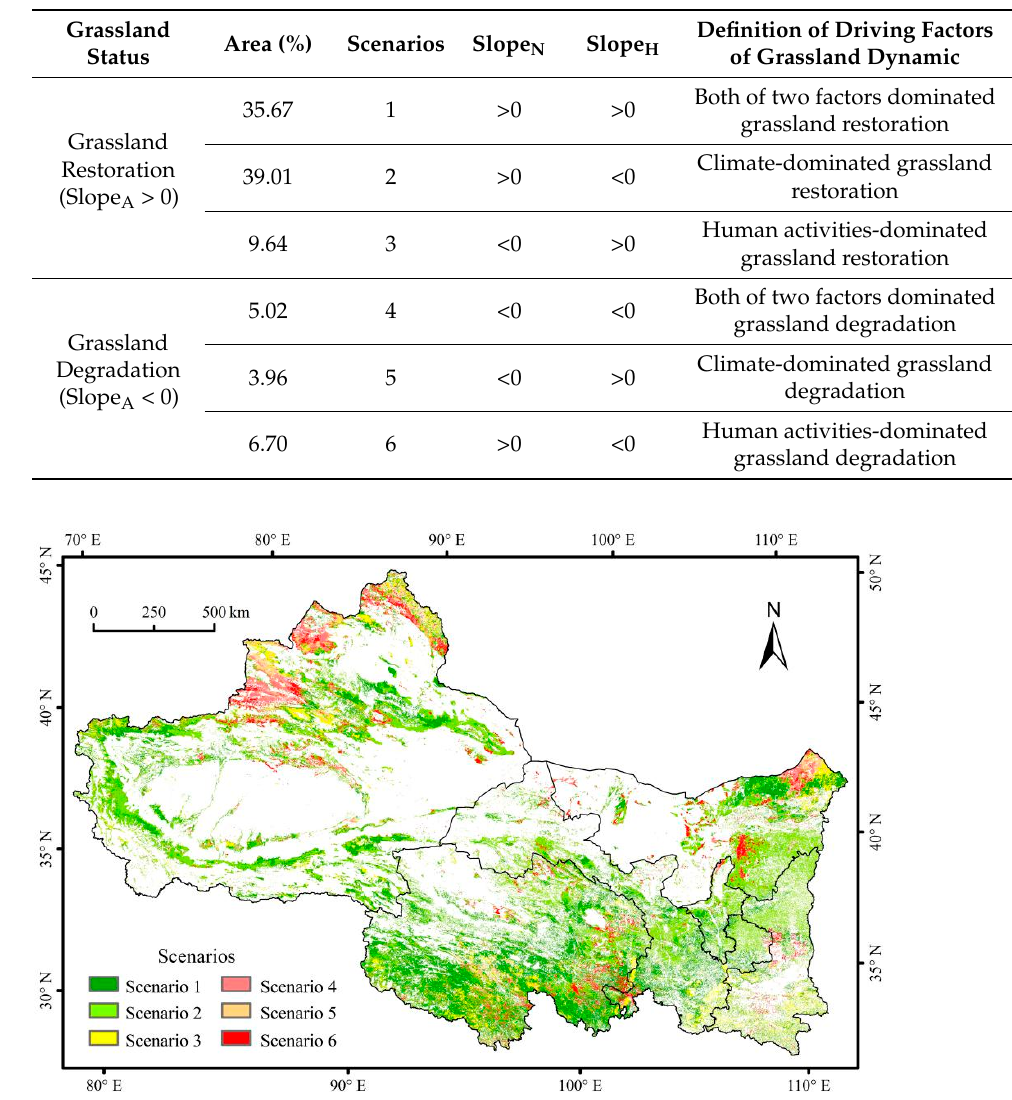
Table 1. The relative effects of human activity and climate change on grassland change.